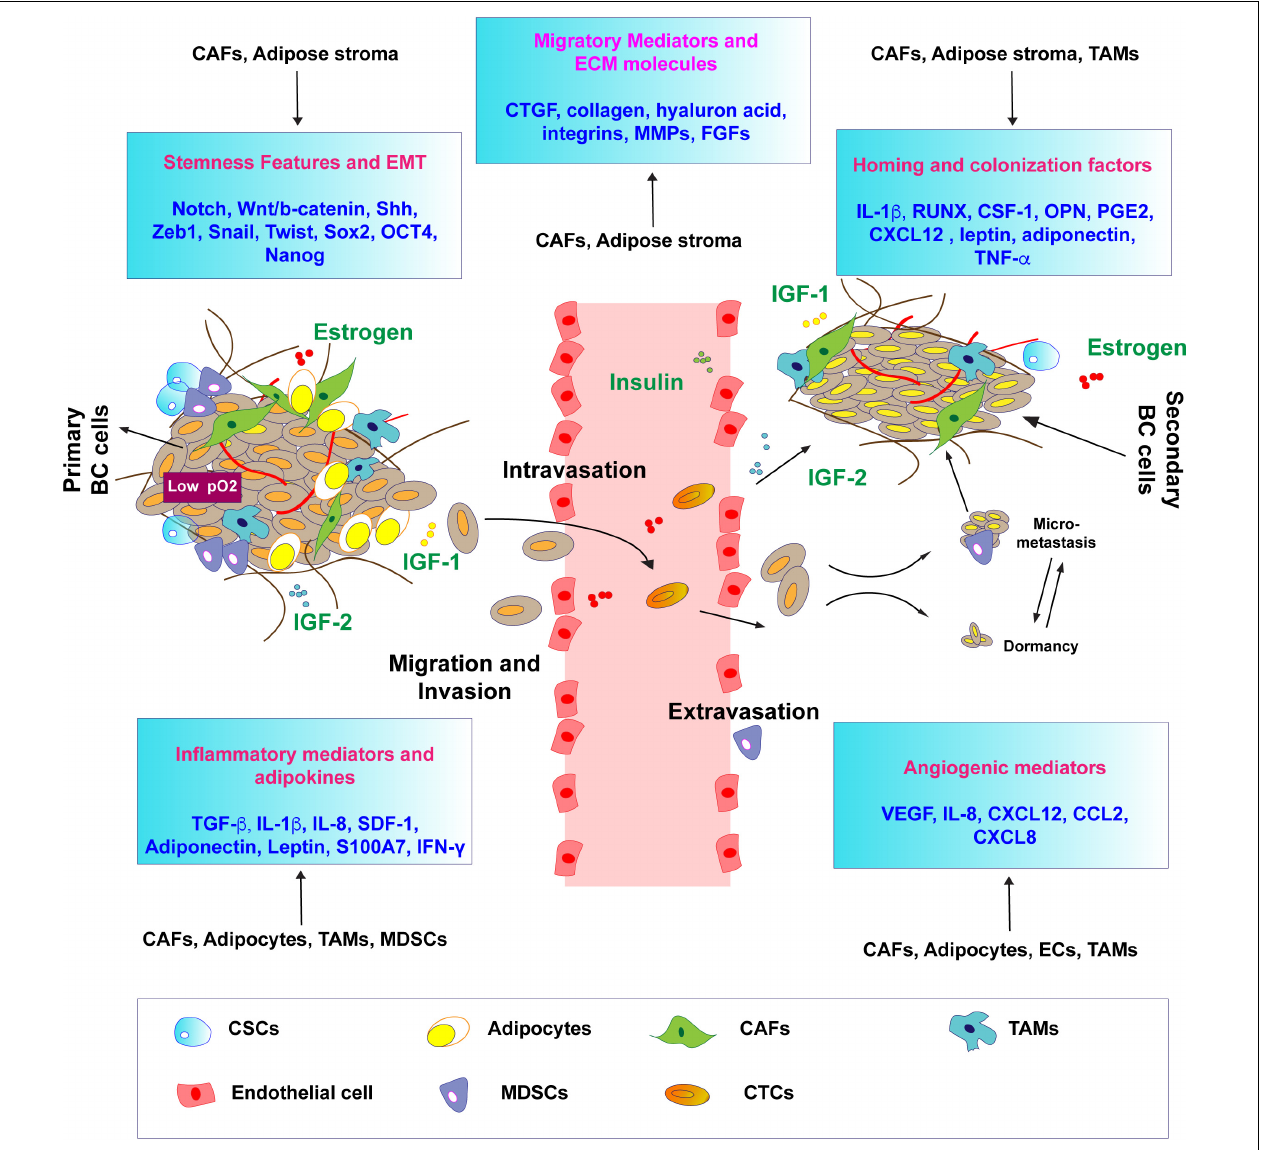
FIGURE 2 | Estrogen and IIGF-prompted microenvironmental responses conducive to BC metastasis. Schematic representation of the main biological responses and shared mediators (in boxes) regulated by both estrogen signaling and by IIGFs, shaping the tumor microenvironment toward metastatic progression. Both estrogen and IIGFs signaling regulate the expression of inflammatory, migratory, and angiogenic mediators by modulating paracrine responses in the tumor microenvironment. The activation of developmental pathways and EMT programs, under the control of estrogen and IIGFs-regulated genes, is responsible for the acquisition of stemness features associated with metastatic progression. Homing and colonization factors under the influence of estrogen and IIGFs trigger BC cells priming to the metastatic sites. CTCs, circulating tumor cell; CSCs, cancer stem cells; CAFs; cancer-associated fibroblasts; TAMs, tumor-associated fibroblasts; MDSCs, myeloid-derived suppressor